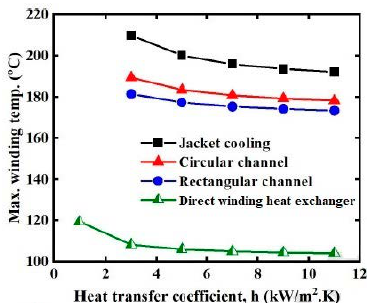
Figure 15. Cooling flow velocity distribution in PMSM at a rotor speed of 35 krpm [77].